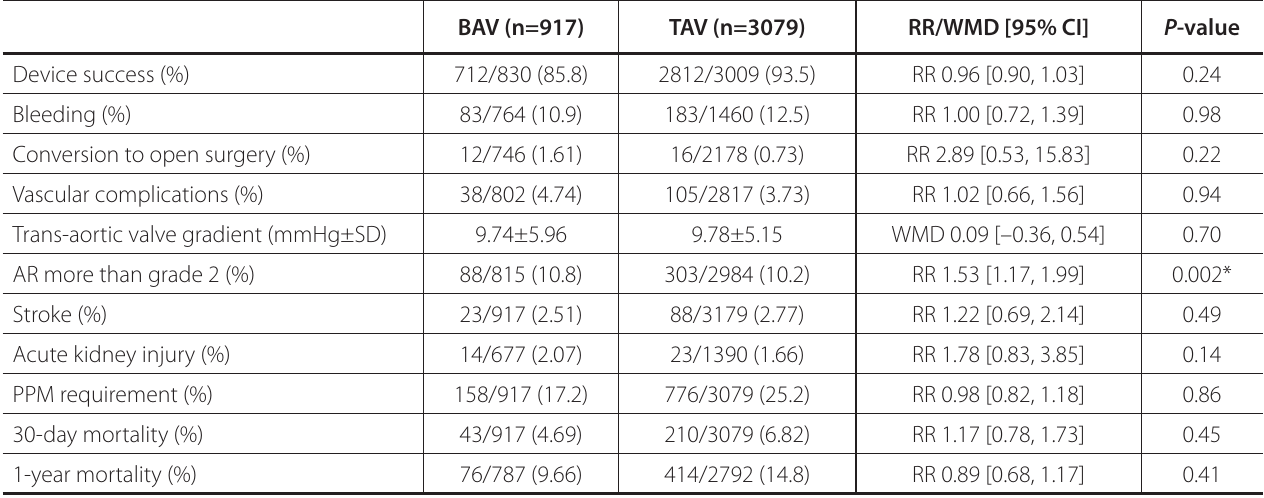
Table 5 . Postoperative outcomes of the included patients. The first number is the number of patients with the event or the sample mean value ± standard deviation of the variable, and the second is the number of patients for whom the event was described. Statistically significant differences were marked with an asterisk (*).